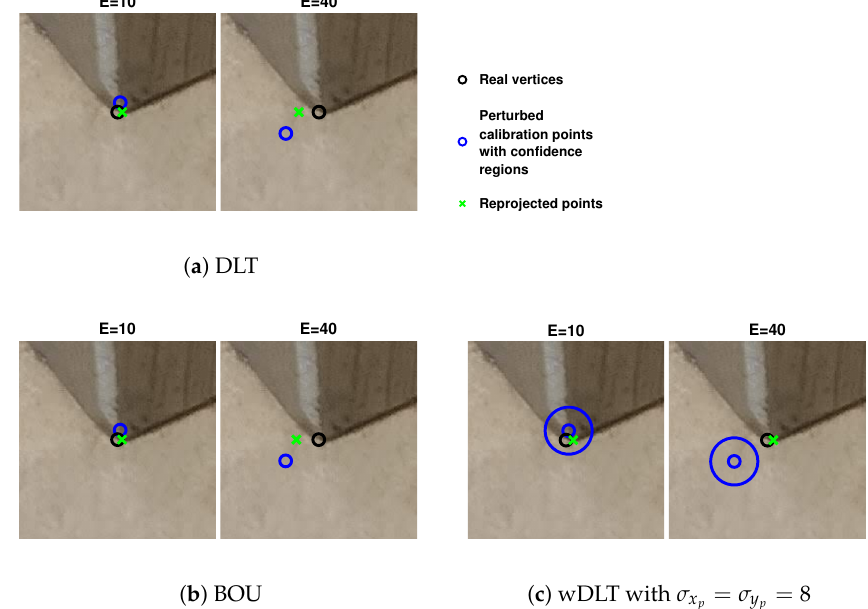
Figure 2. Example: Here, the calibration is performed on the seventh image (Photo Credits: Copyright 2020 Baker Hughes Company. All rights reserved. ) with an error E on a control point of 10 and 40 pixels. The black circles are the unperturbed position of the control point, while in blue, we show the perturbed ones. In Figure 2c, the confidence region is shown as well: the radius of the circles is 24 pixels, corresponding to σ =8. Here, wDLT can recover an error of 40 pixels on a single perturbed point, while DLT and BOU